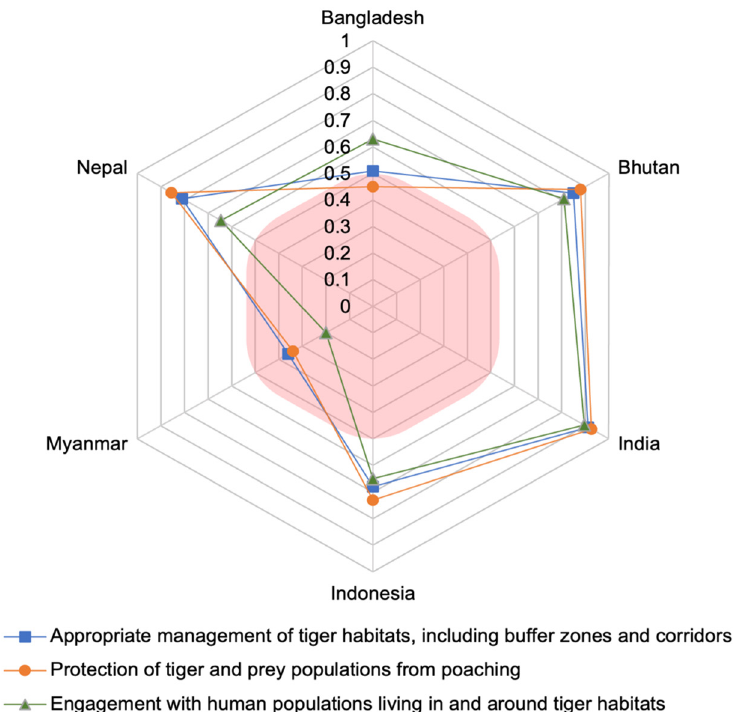
Figure 5. Average per country of mean CA|TS Lite assessment score for the ITHCP pillars: 1 = Recognized—Action Implemented, 0.75 = Recognized—Action Initiated, 0.5 = Recognized—Action in Planning Process, 0.25 = Recognized—No Action Initiated, 0 = Not Recognized—Action Absent. Categories that score below 0.5 (shown in light red) are considered to be insufficiently addressed [24].